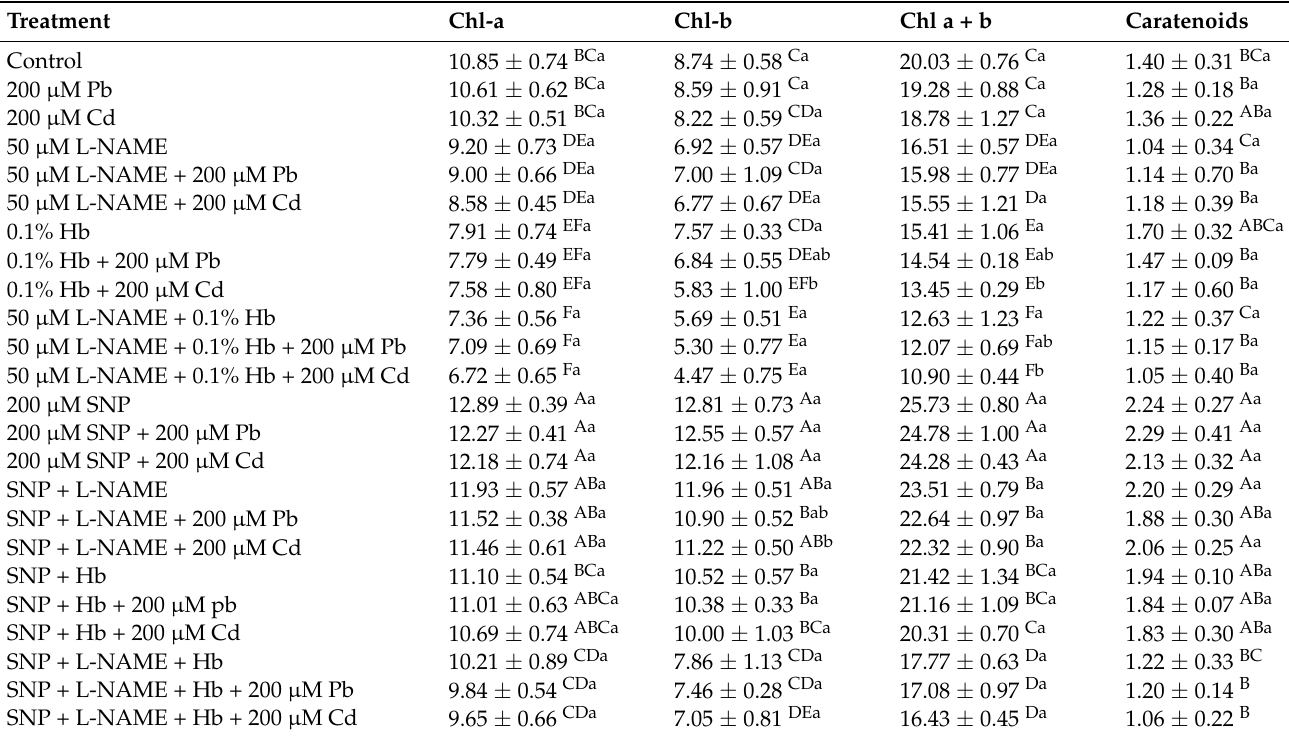
Each data point is the mean ± SE of four replicates. The treatments contained levels of nitric oxide (L-NAME, N(G)-nitro-L-arginine methyl ester (NO synthase inhibitor)); 0.1% Hb, bovine hemoglobin (NO scavenger), and NO donor, sodium nitroprusside (SNP) alone and in combination with each other, as well as in combination with 200 µ M Pb and 200 µ M Cd. The capital letters indicated statistically significant differences across various levels of nitric oxide alone or in combination with 200 µ M Pb and 20 µ M Cd, while the lowercase letters displayed statistically significant differences within each level of nitric oxide alone and in combination with 200 µ M Pb and 200 µ M Cd, based on Tukey (cid:48) s test ( p < 0.05). They are superscripted on top of the